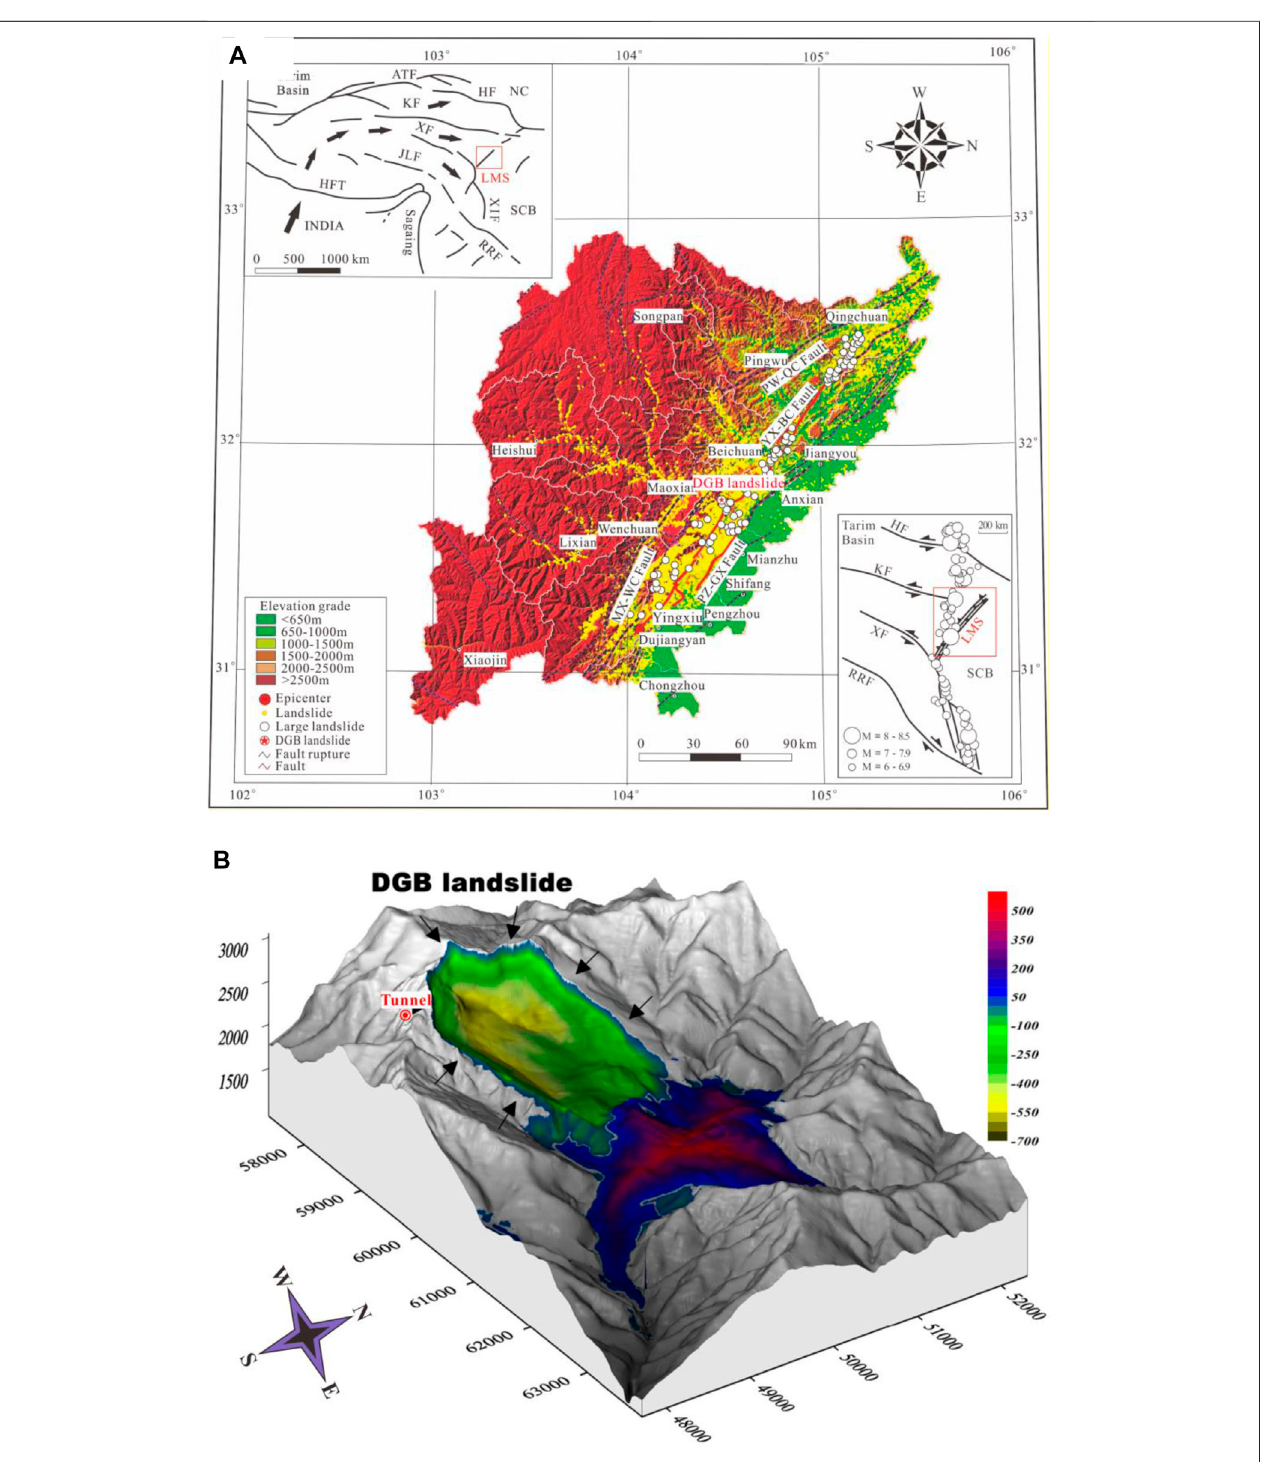
FIGURE 1 | The location (A) and 3D topography (B) of the DGB landslide.